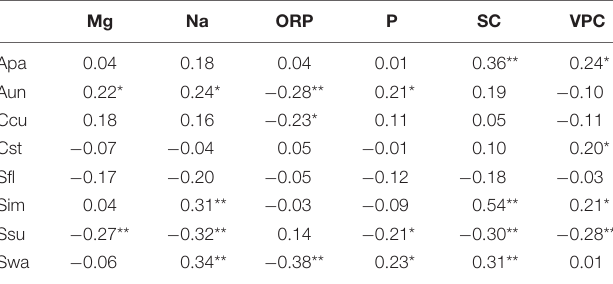
TABLE 4 | The Pearson correlation between environmental variables and bryophyte cover.